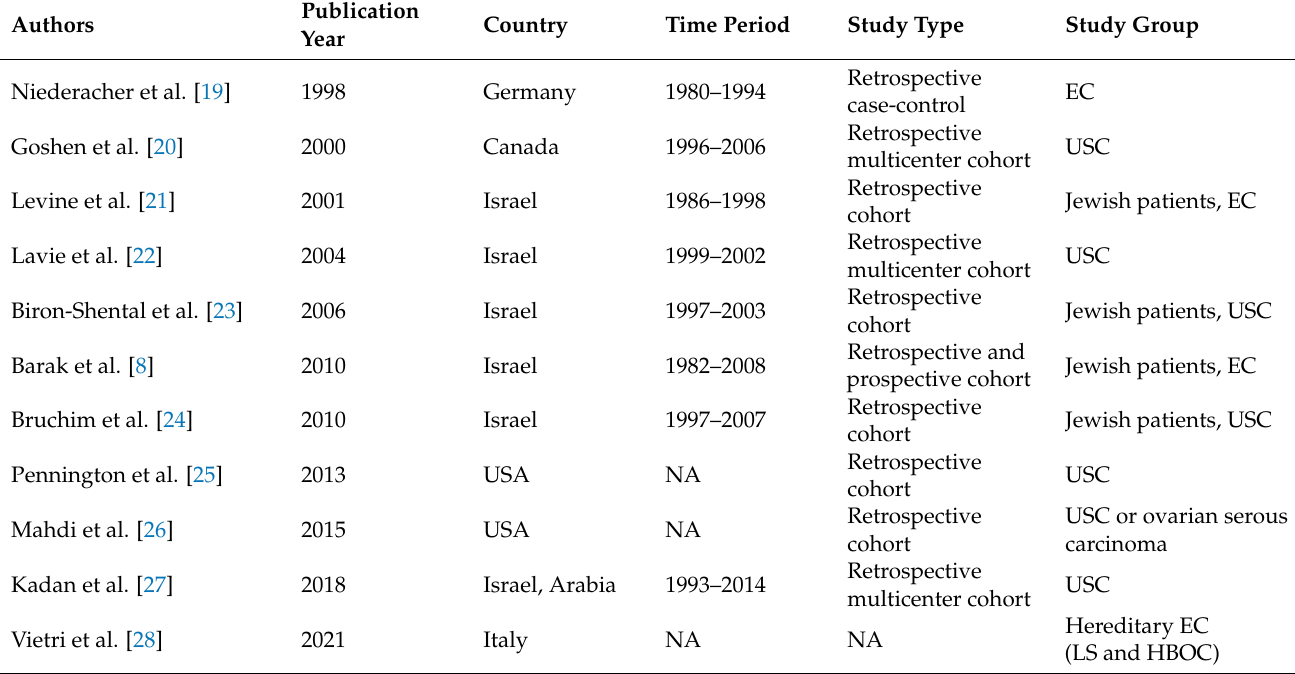
Table 1. Characteristics of the included studies on the prevalence of BRCAm in patients with endometrial